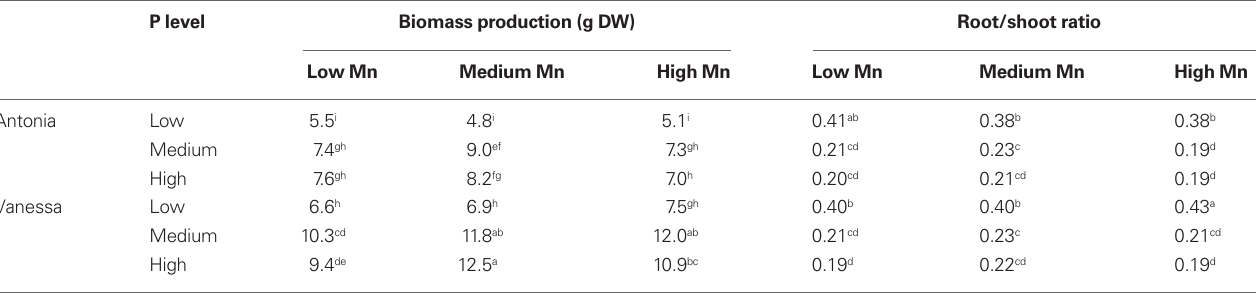
Table 2 | Total biomass (shoot + root) and root/shoot ratios of barley genotypes Antonia and Vanessa grown in a hydroponic system at different Mn and P